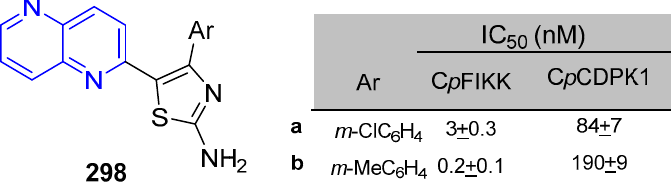
Figure 22. Inhibition of CpFIKK and CDPK1 kinases by a 1,5-naphthyridine aminothiazole derivative.